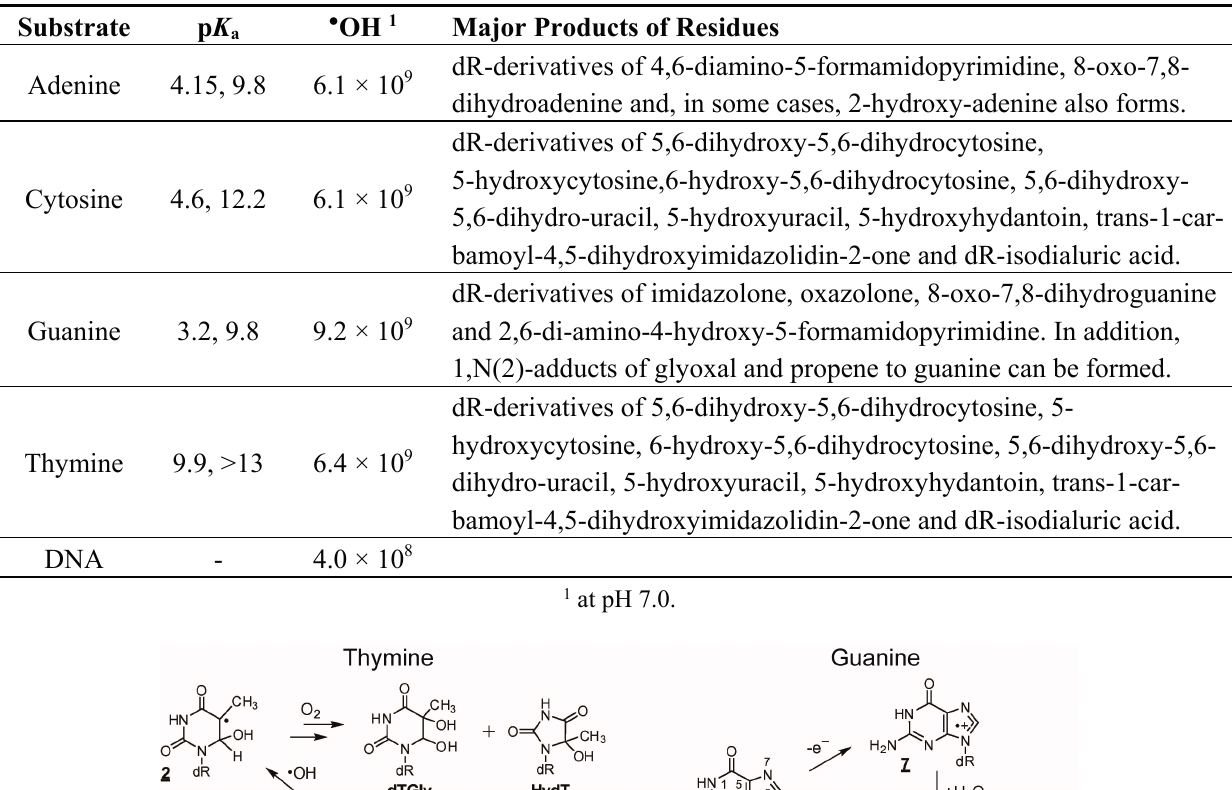
Table 4. Rate constants (in L·mol − 1 ·s − 1 ) and major products for reactions of nucleobases and DNA with ● OH ([92,96,126]).